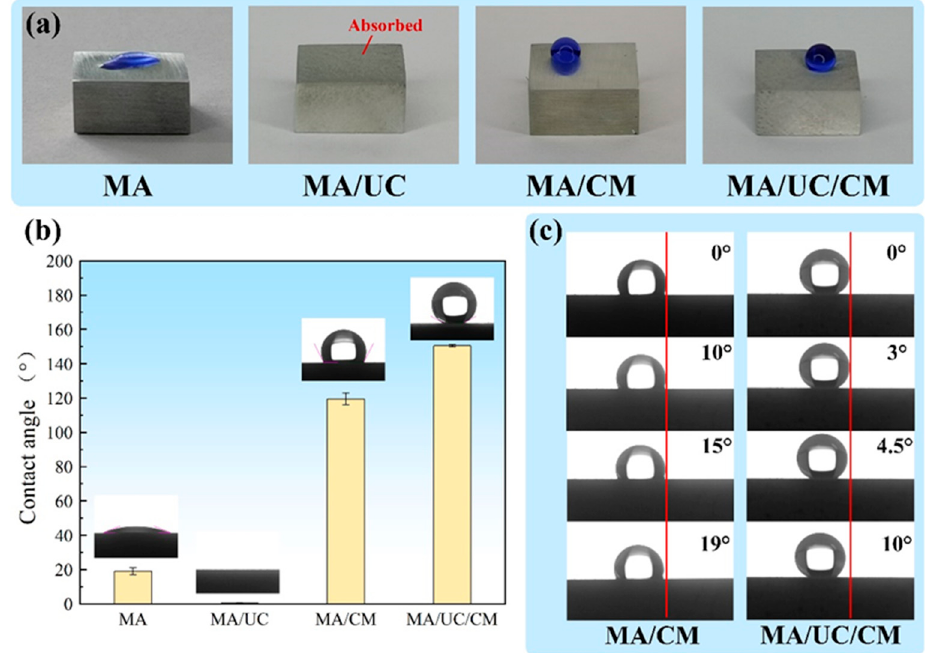
Figure 6. ( a ) Macro-wettability of the investigated samples; ( b ) water contact angle of the investi- gated samples; ( c ) sliding angle of the hydrophobic samples.